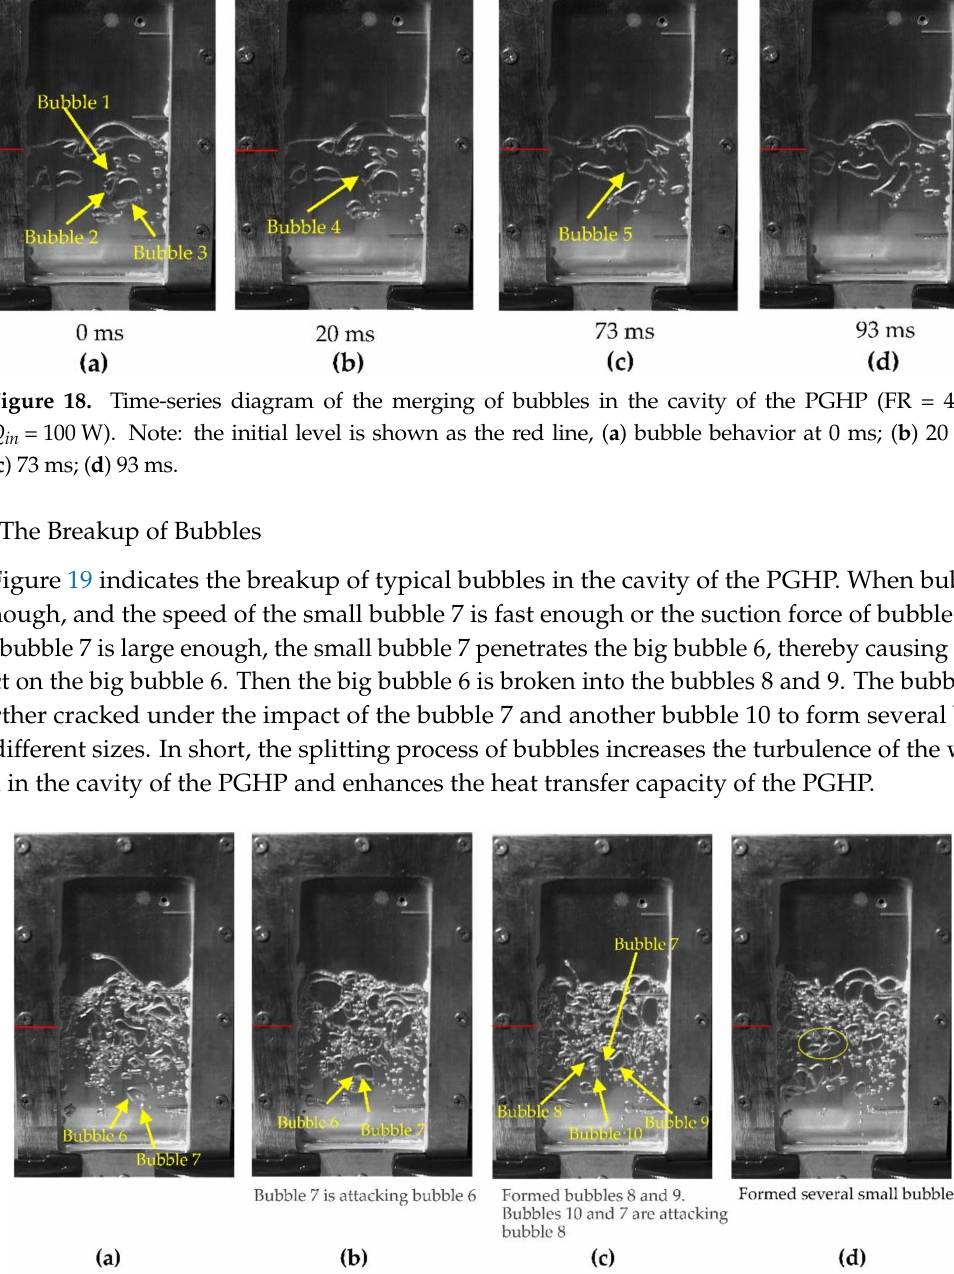
Figure 19. Time-series diagram of the breakup of bubbles in the cavity of the PGHP (FR = 48%, Q in = 120 W, ∆ t = 52 ms). Note: the initial level is shown as the red line, ( a ) bubble behavior at 0 ms; ( b ) 52 ms; ( c ) 104 ms; ( d ) 156